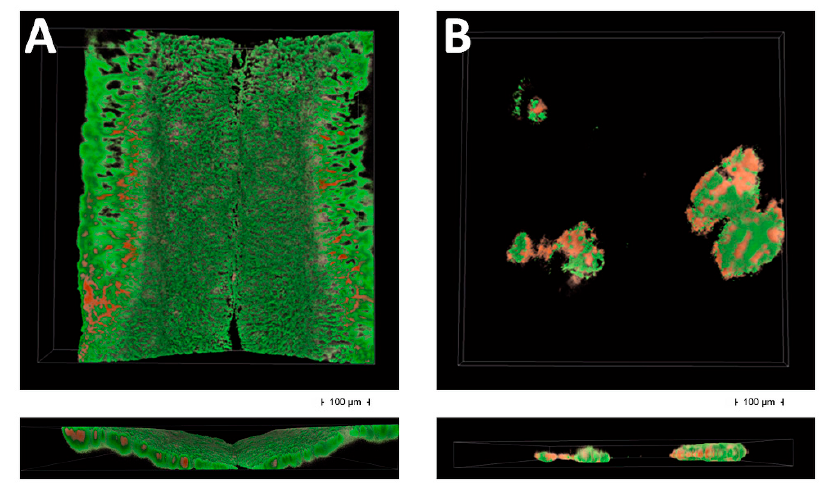
Figure 4. CLSM analysis. Three-dimensional reconstructions of 750 × 750 µ m fields from the specimens exposed to the oral environment. Live / Dead stain colors viable microorganisms in green, while the nonviable ones are shown in red. ( A ) space between two threads of a control implant; ( B ) test implant.